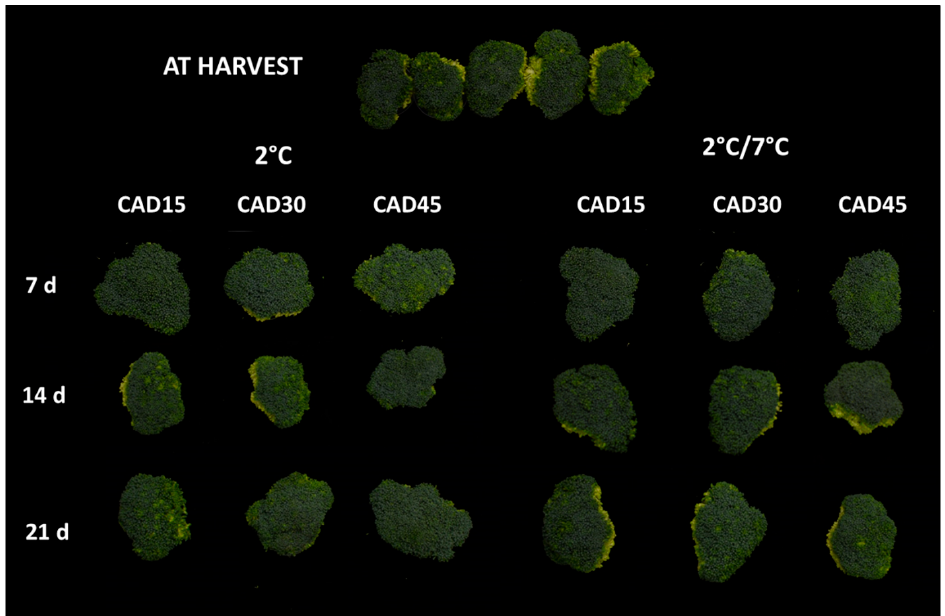
Figure 3. Evolution of visual quality of broccoli florets packaged in films with different levels of micro-perforations (CAD15, CAD30 and CAD45) and stored at two conditions of temperature (2 °C and 2 °C/7 °C) during 21 d.